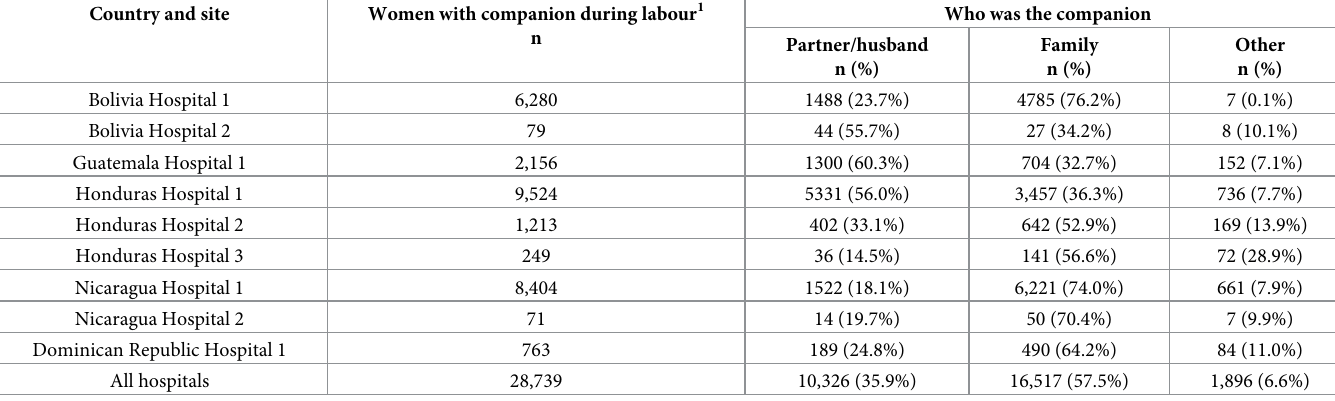
Table 4. Labour companion’s relationship to the woman from SIP sentinel data in nine Latin American hospitals. Country and